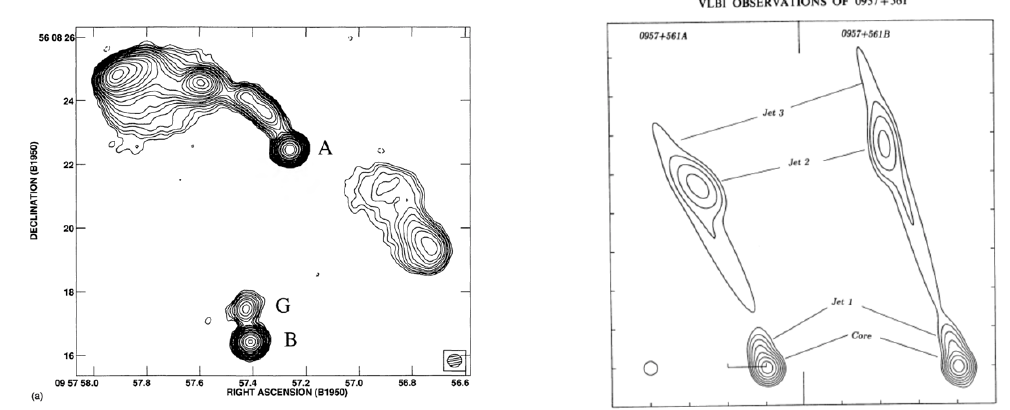
Figure 9. The left panel shows a 6-cm VLA map of the QSO 0957 + 561 [82] where besides the two QSO and the extended radio structure seen for image A, radio emission from the lens galaxy G is also visible. The milli-arcsecond structure of the two compact components A, B is shown in the lower right panel [83] where it is clearly seen that one VLBI jet is a linearly transformed version of the other, and they are mirror symmetric; this is predicted by any generic lens model which assigns opposite parity to the two images. Images credits: [80,82,83].